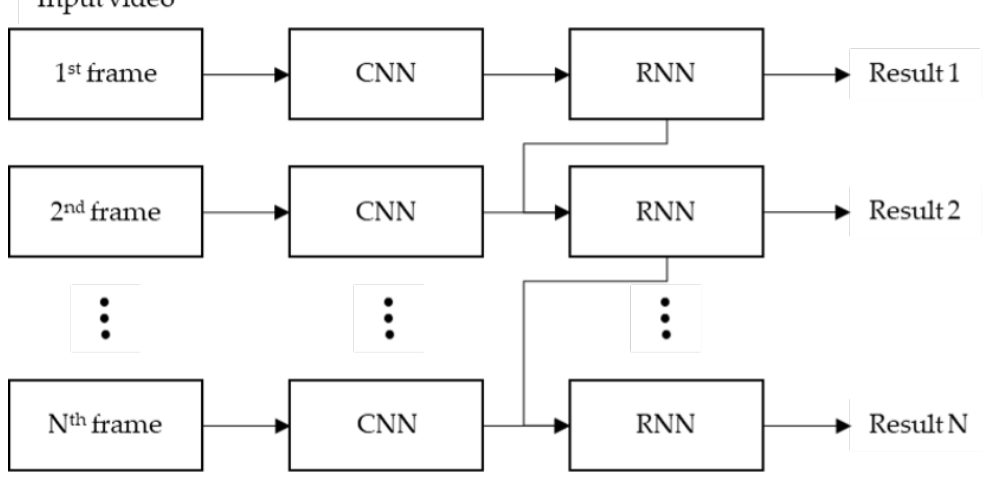
Figure 2. Structure of a motion recognition model using CNN-RNN